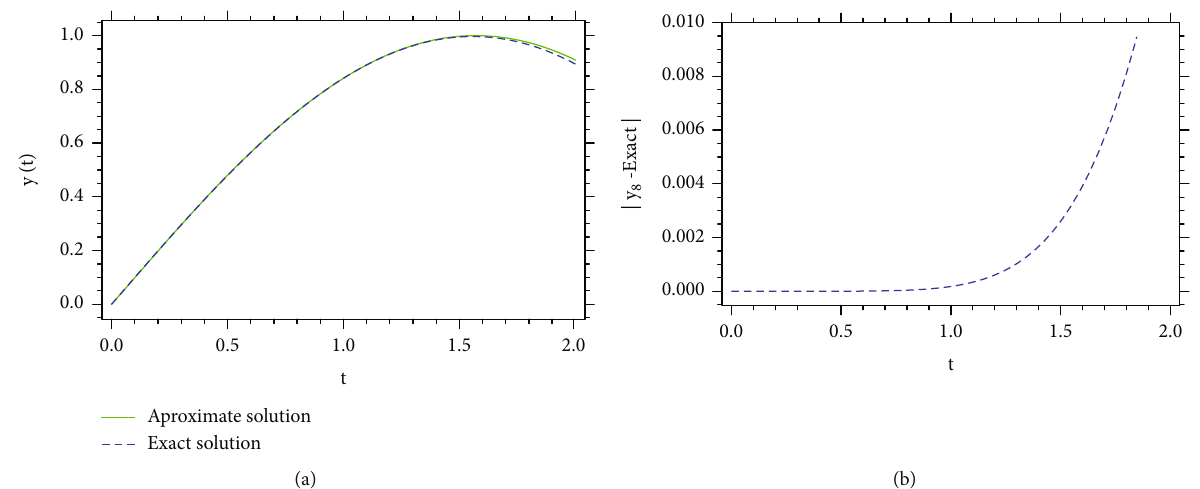
Figure 1: (a) 2D solution plots of Example 1 obtained by the present method in comparison with the exact solutions : (b) The absolute errors of Example